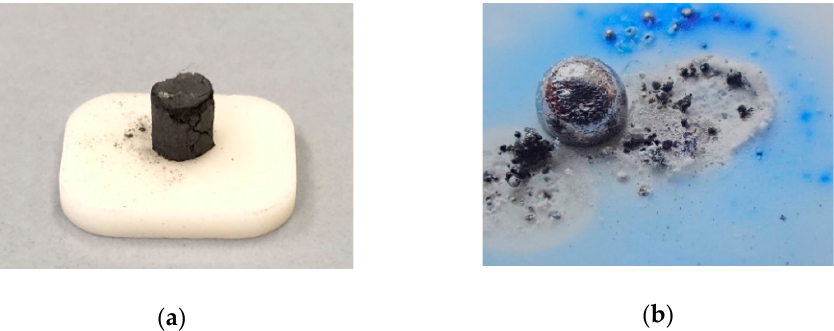
Figure 4. ( a ) NMC_C sample before and ( b ) after heating to 1600 °C in the heating microscope.